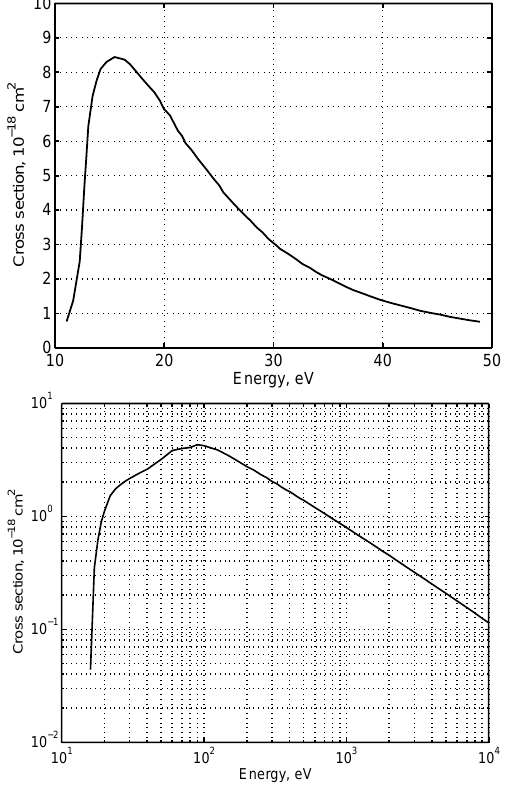
Fig. 3. Emission cross-sections of the 777.4nm muliplet: top – electron impact on atomic oxygen (derived from Julienne and Davis, 1976), bottom – dissociative excitation of O 2 (Erdman and Zipf,